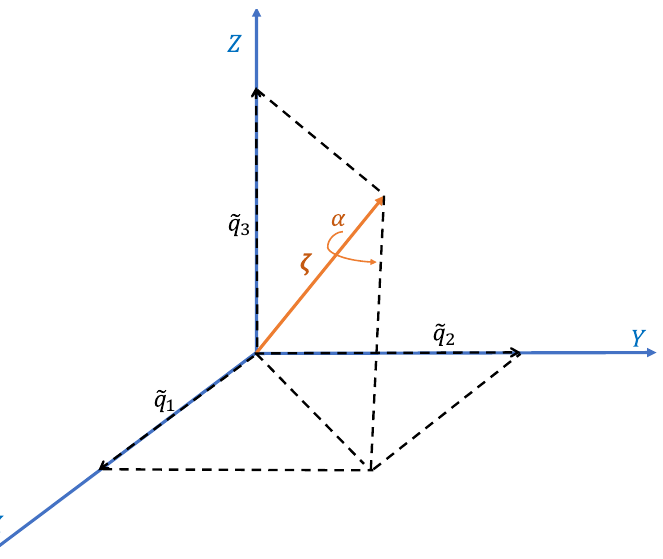
Figure 3. Geometrical meaning of quaternion: a rotation around the ζ axis by a given angle α is defined by the unit quaternion ˜q = [ ˜ q 0 , ˜ q 1 , ˜ q 2 , ˜ q 3 ] T , whose components are ˜ q 1 = ζ x , ˜ q 2 = ζ y , ˜ q 3 = ζ z and ˜ q 0 = cos α